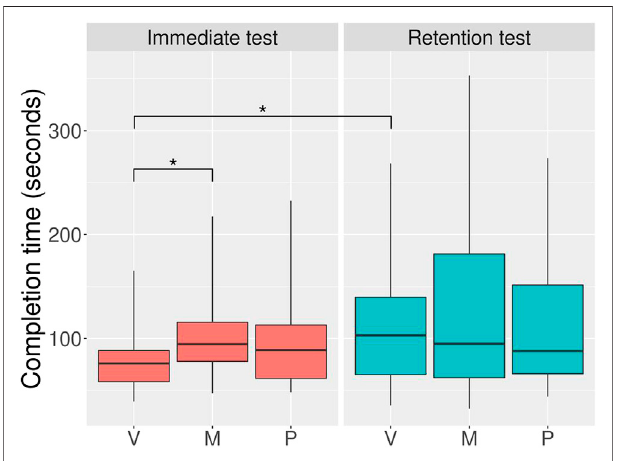
FIGURE 8 | Completion times for each condition in the immediate test and the retention test. *means signi fi cant difference ( p < 0.05).